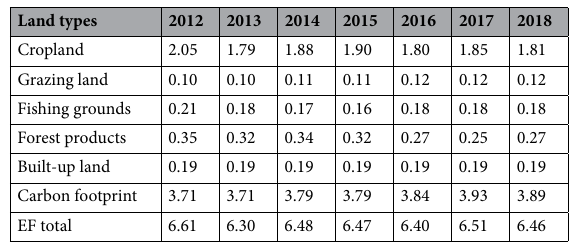
Table 3. Footprints of six types of bioproductive land from 2012 to 2018 (unit: gha).